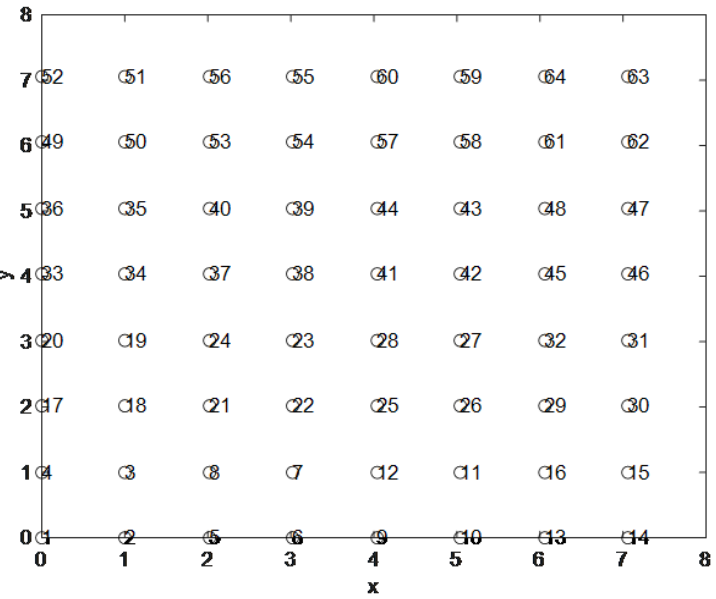
Figure 11. Positions of the 64-element planar phased array